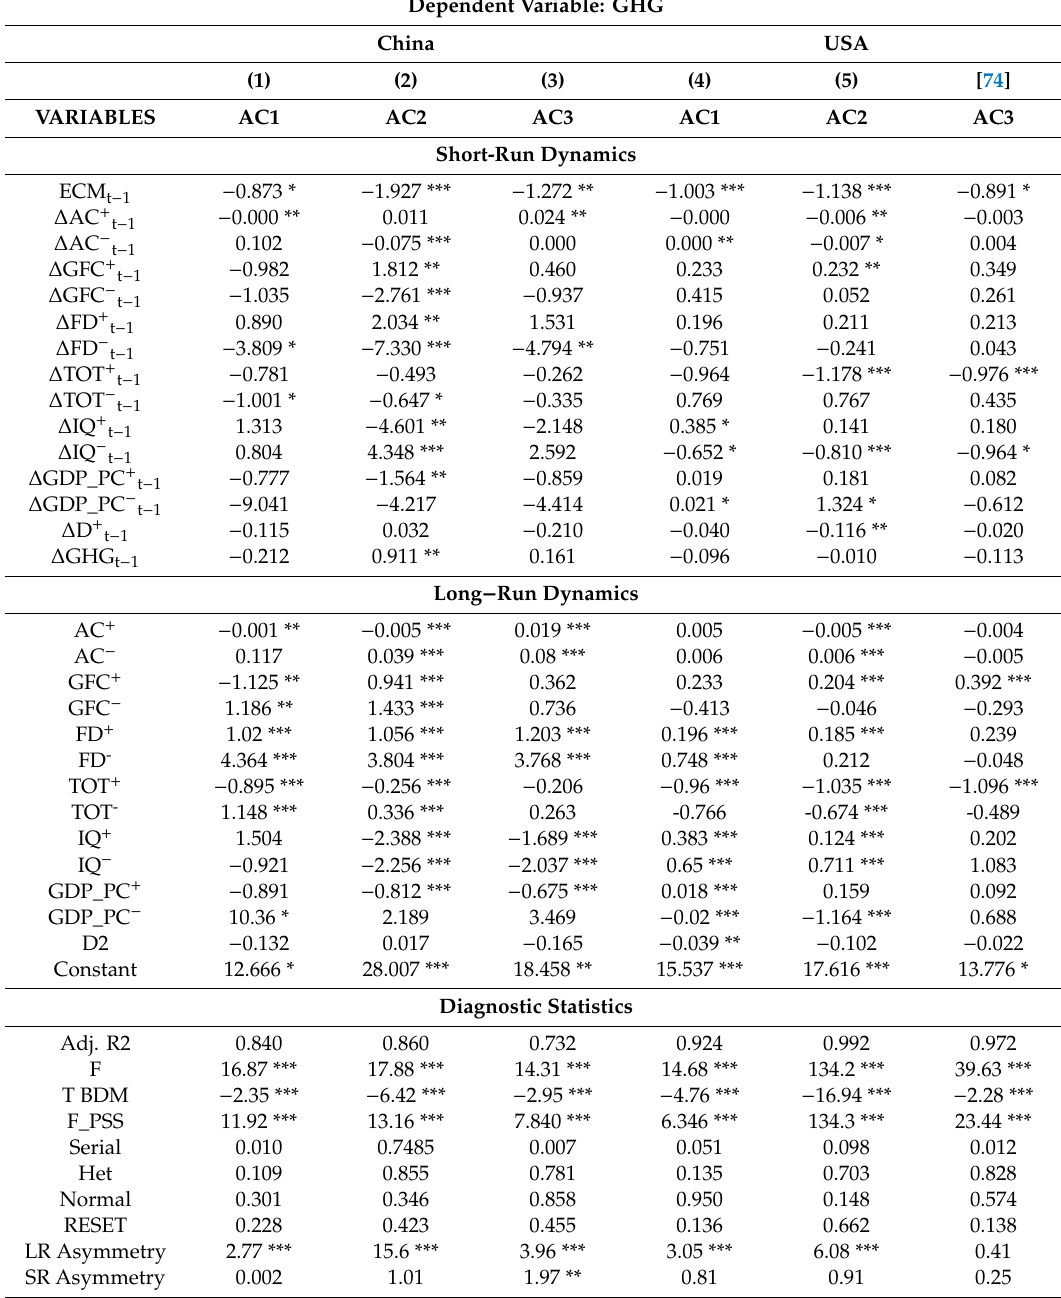
Table 5. Robustness with an alternative measure